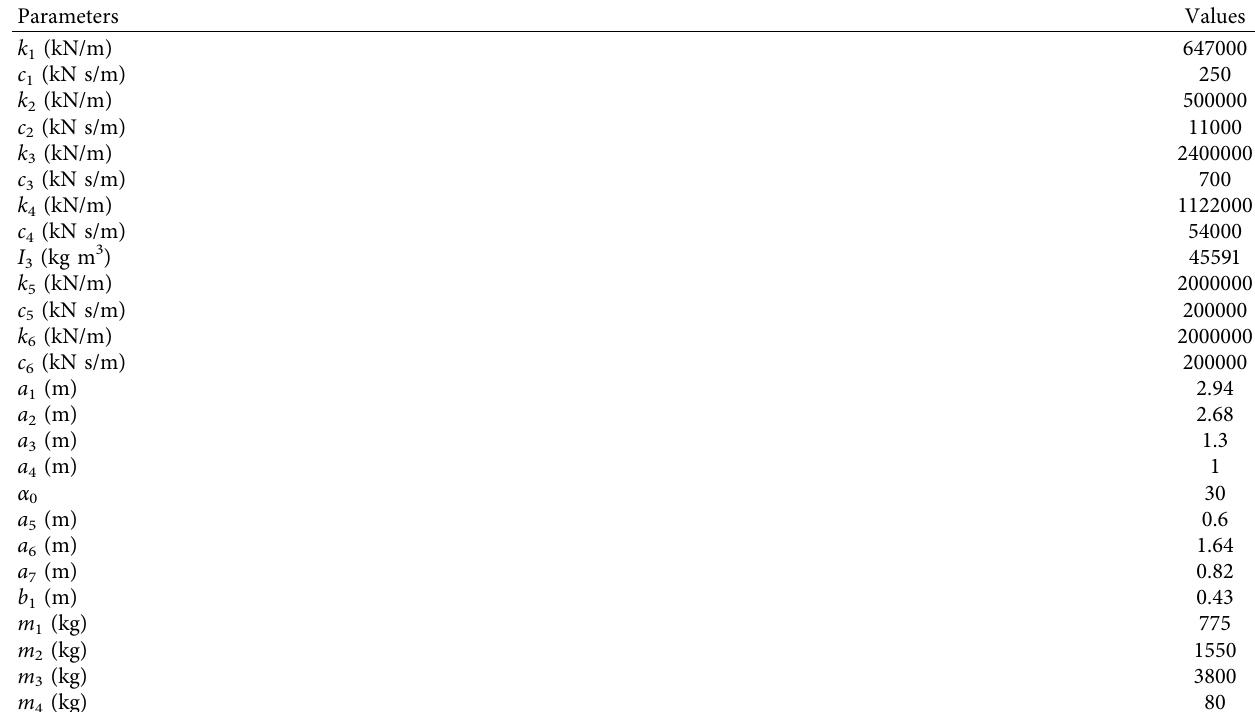
Table 1: Parameters of the system used for dynamical process modelling [7, 16, 17].